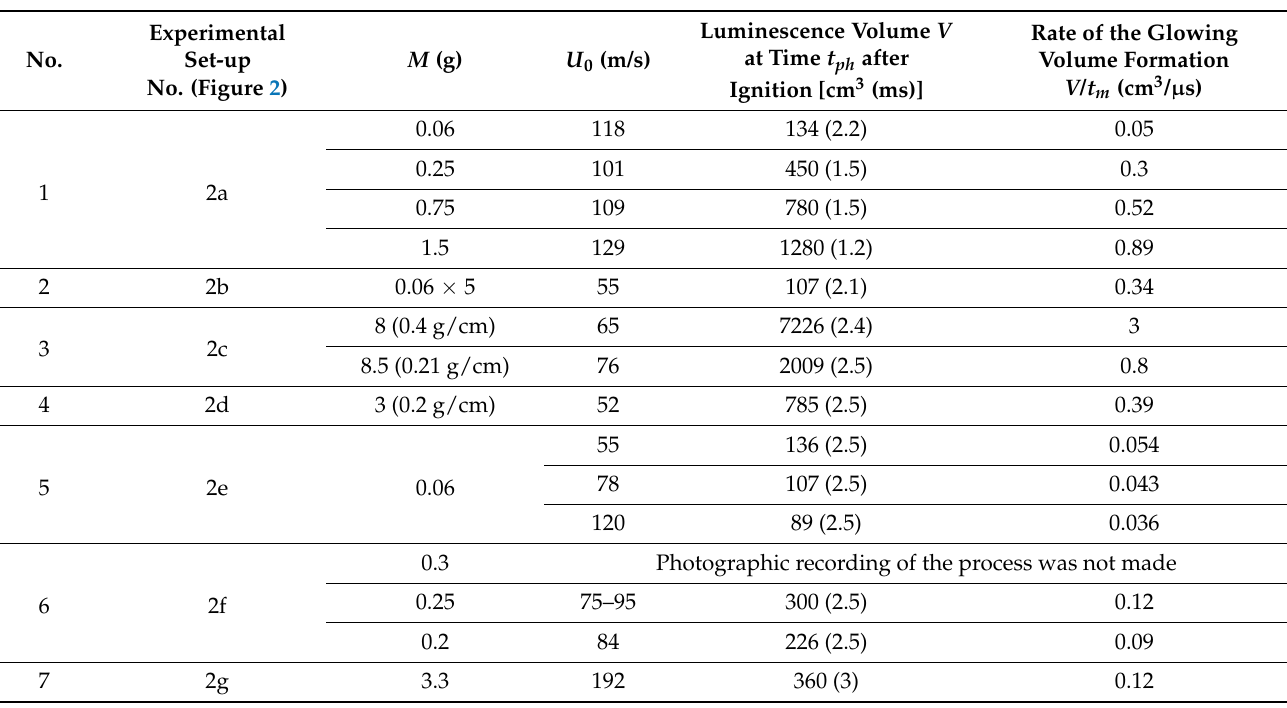
Table 1. Some results on the dynamics of the flame region of Al/CuO 19/81 mixture for various experimental